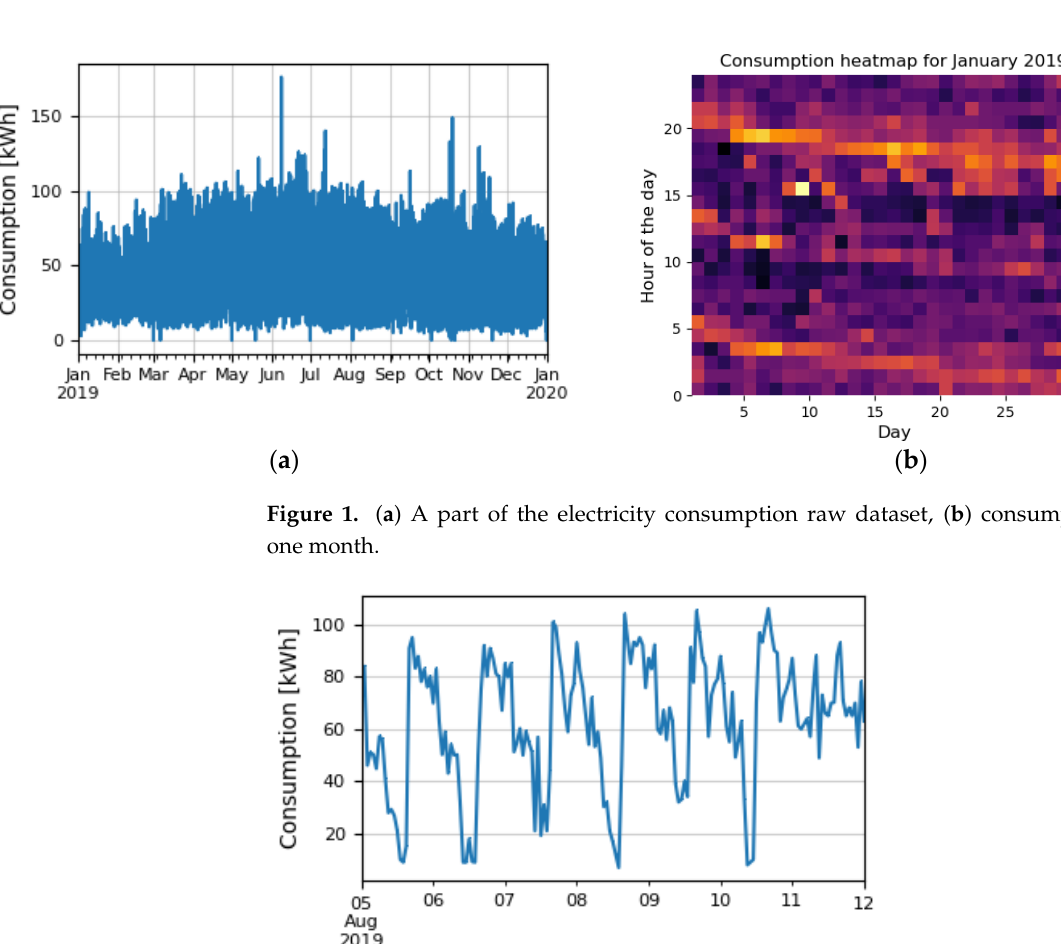
Figure 2. Single week seasonal pattern.